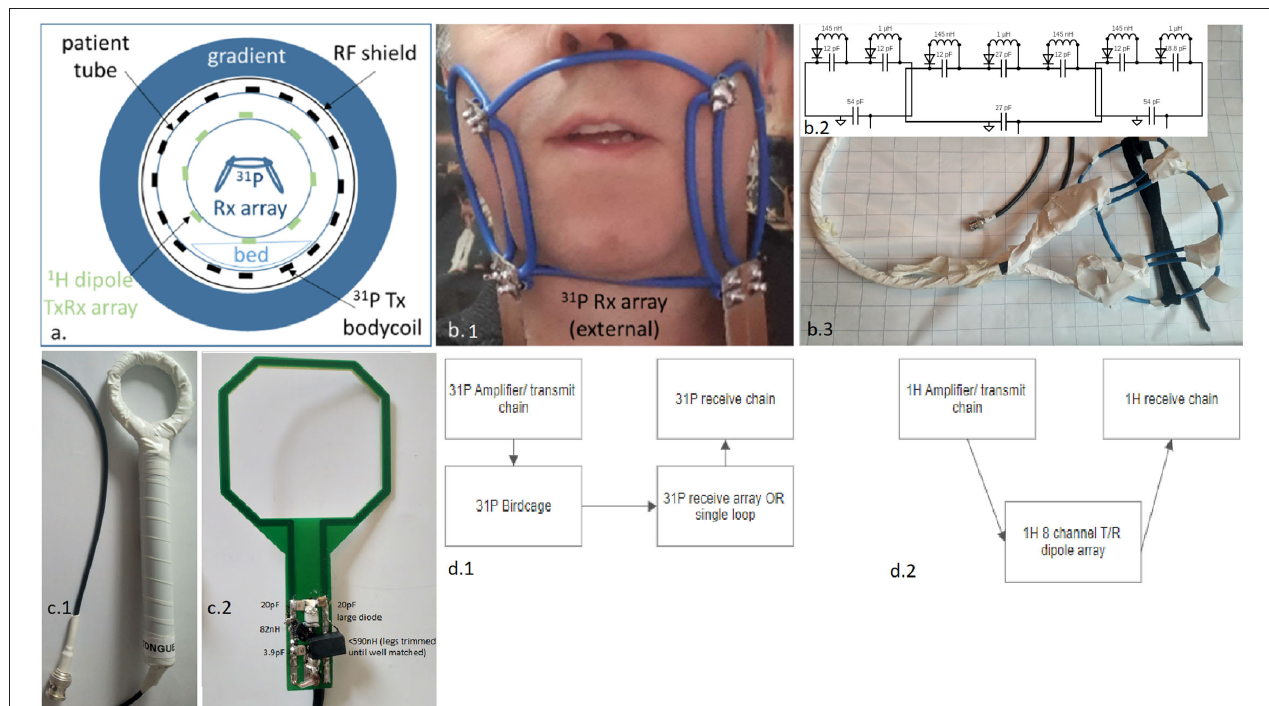
FIGURE 1 | Representation of the used complete RF setup expressed in a schematic overview (a) , as a photo when positioned on a subject, zoomed onto the external three-channel receiver array (b1) , a circuit schematic of the three-channel array (representative only—not to scale) with all component values (b2) , photo of three-channel array with insulation (b3) , and the reference intra-oral/ insert coil; shown with insulation present (c1) , and without insulation present and with component values indicated on photo (c2) , and the block schematic of the 31 P (d1) and the 1 H transmit and receive chains (d2)